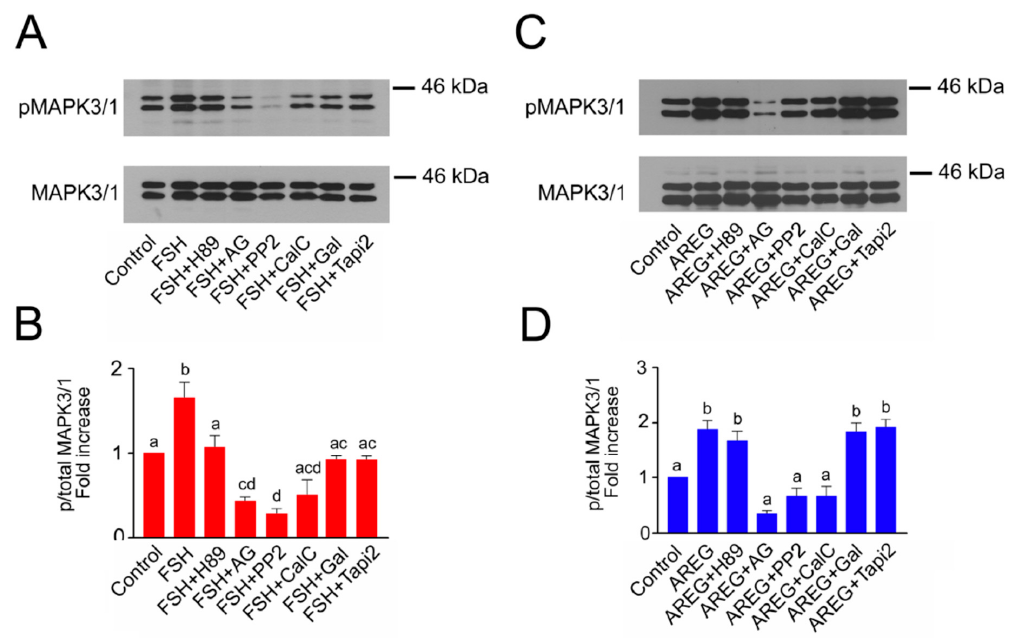
Figure 3. Effect of protein kinase and proteinase inhibitors on maintenance of FSH- and AREG-induced activation of MAPK3/1 in pig COCs. The panels show representative results of immunoblotting of phosphorylated and total MAPK3/1 in samples of 25 COCs cultured in vitro for 16 h. The experiments were repeated three times. Quantification of the activated MAPK3/1 was performed by densitometry and is shown in the graphs as proportions of phosphorylated and total MAPK3/1 and expressed in arbitrary units as the fold increase over the proportion found in unstimulated COCs at the beginning of the culture. ( A , B ) show COCs stimulated by FSH; ( C , D ) show COCs stimulated by AREG. The different superscripts above the columns ( D ) or superscripts with no common letters ( B ) indicate significant differences ( p < 0.05). AG: AG1478; CalC: calphostin C; Gal: